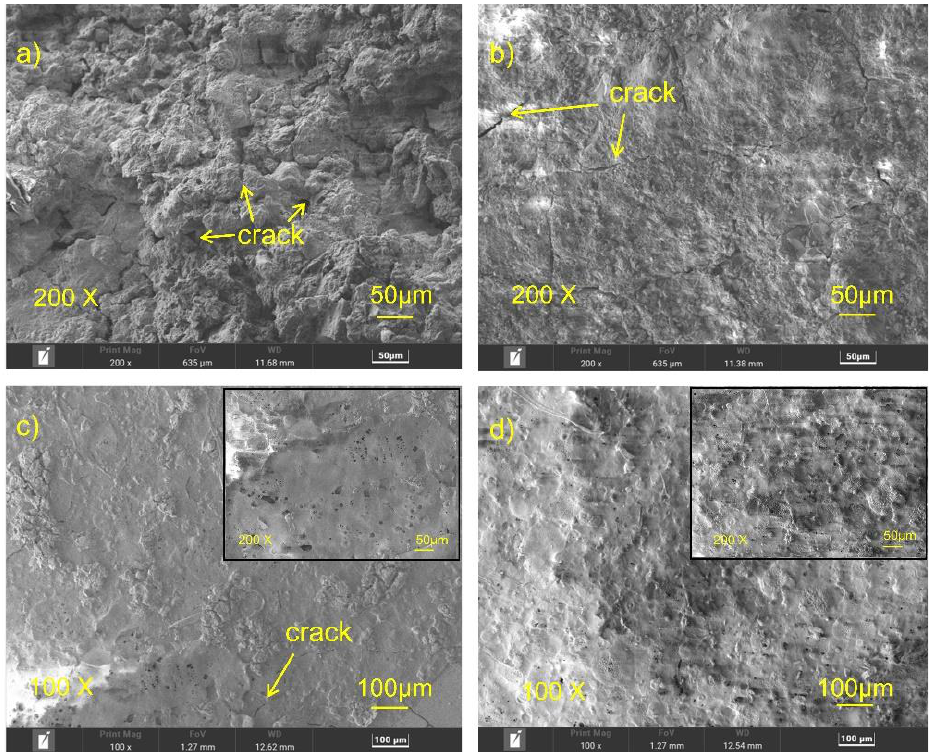
Figure 9. SEM image of all samples after immersion in SBF for 15 days ( a ) bare Mg, ( b ) HF-Mg and ( c ) PLLA (5)-HF-Mg, ( d ) PLLA (10)-HF-Mg.